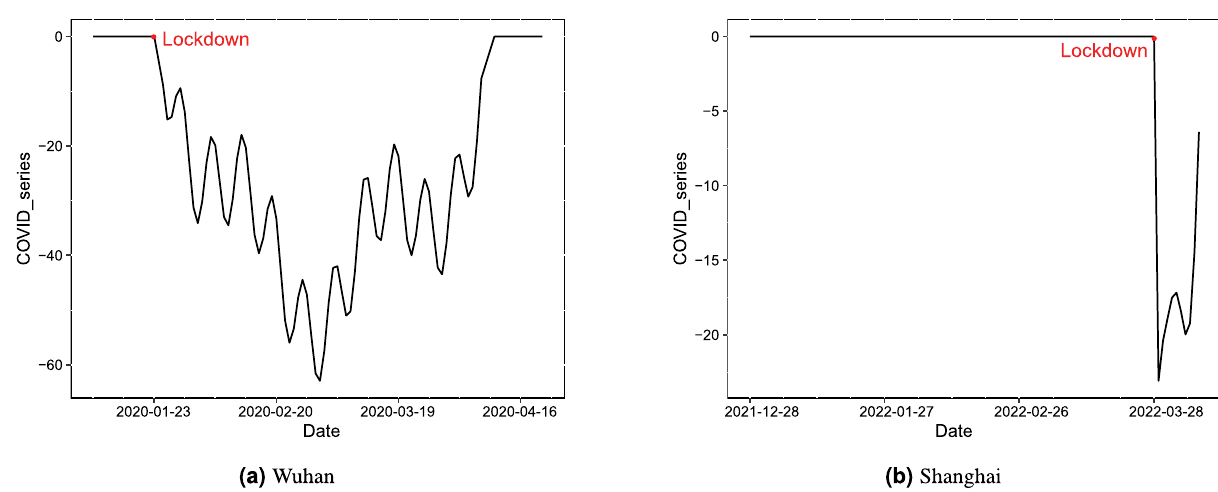
Figure 6. The impacts of the lockdown policy on AQI in two